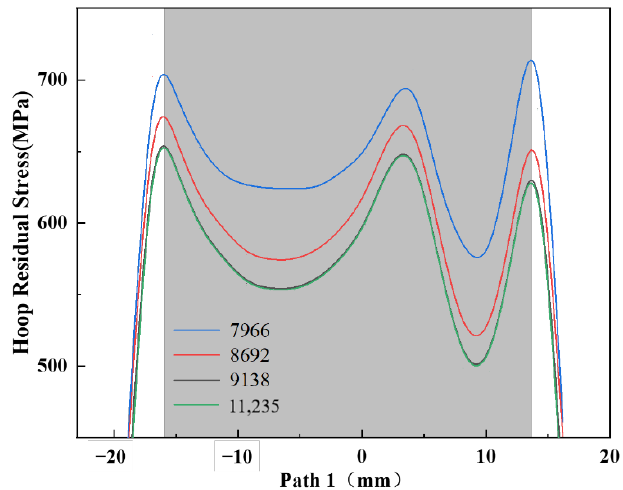
Figure 6. Grid independence verification.